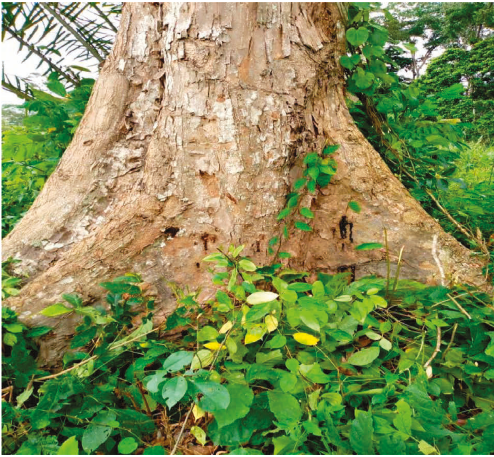
Figure 4. We used a Phenol-Resorcinol-Formaldehyde (PRF) type adhesive combined with a HRP-155 hardener.